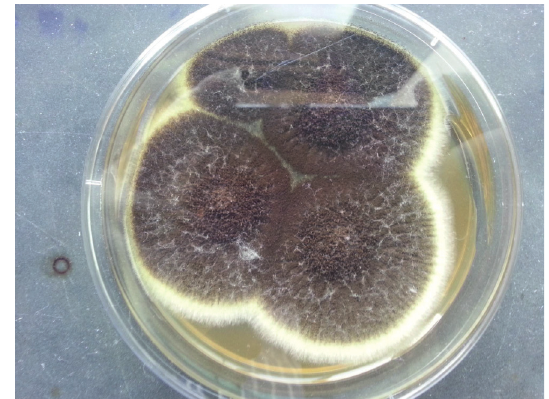
Figure 4: Aspergillus spp. observed as dark brown/black colonies grown on the SDA medium.